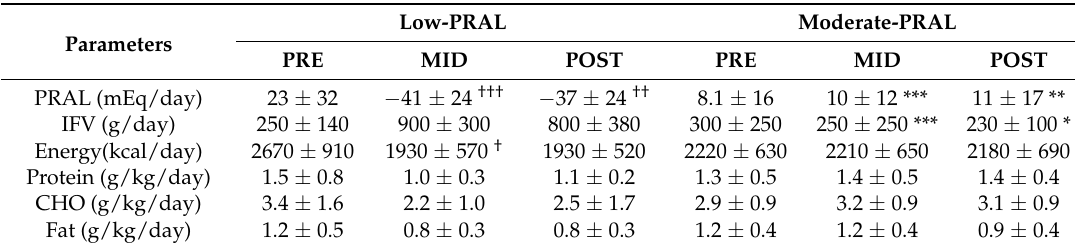
Table 2. Dietary intake data in men before (PRE), in the middle (MID) and after (POST) the 12-week diet period.